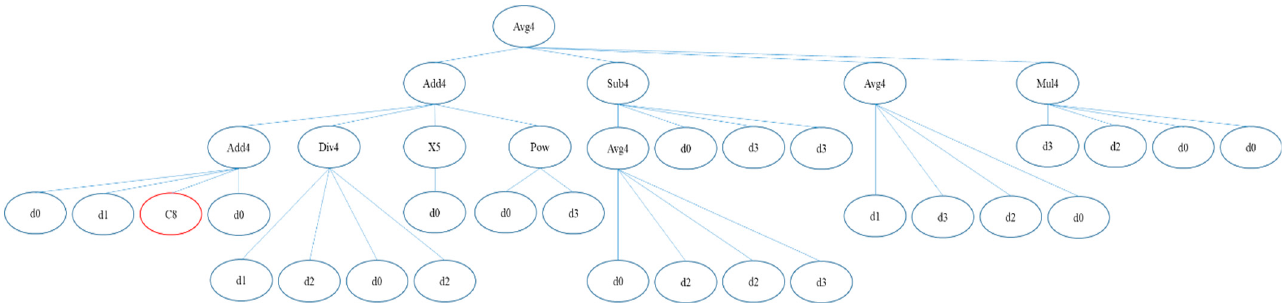
Figure A3. Sub-ET3 of GEP bathymetry retrieval model.